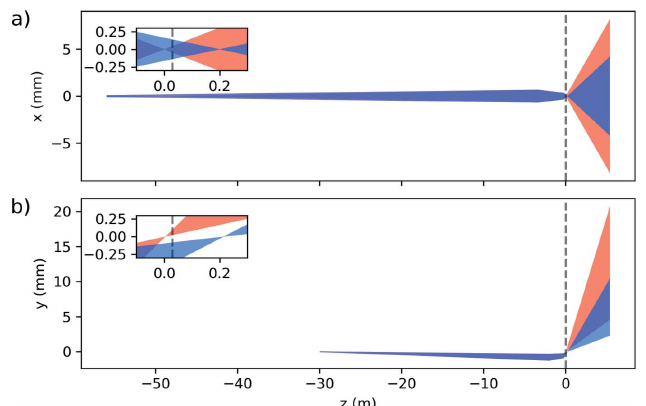
Figure 2 ( a ) Horizontal and ( b ) vertical beam propagation from the intermediate source point to the detector. The position of the sample is shown as a dashed vertical line. The inset in each figure shows a zoomed-in region around the sample position. The red-filled areas represent the 707 eV photon beams from the fundamental harmonic of the undulators. The blue-filled areas represent the beams at 1414 eV photon energy originating from the second harmonic of the undulators. The vertical separation between fundamental and second-harmonic beams near the zone-plate focus arising from the off-axis component of the diffractive optics can be used to block the unwanted radiation.